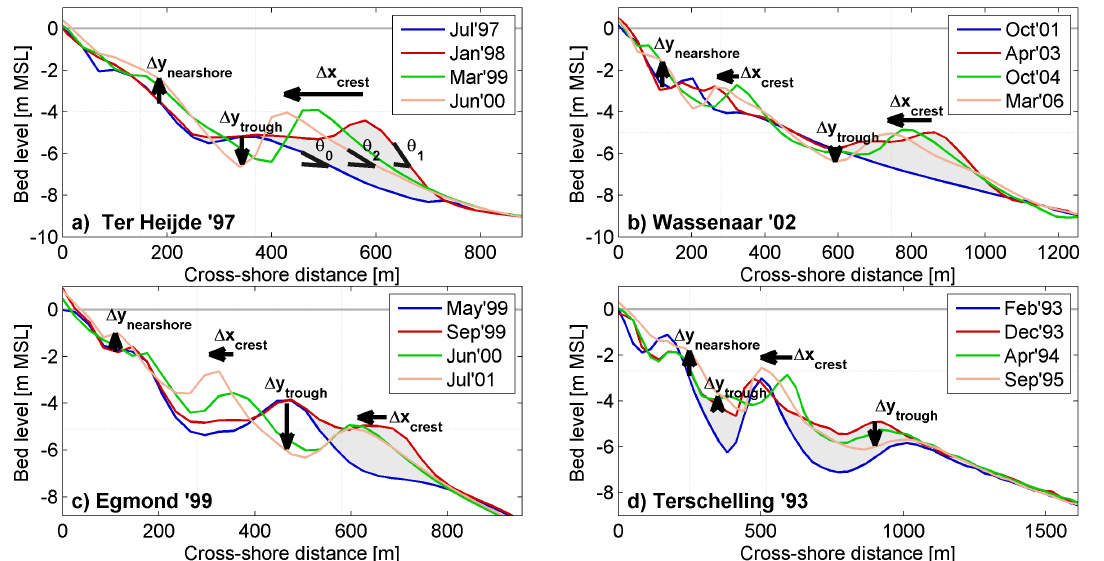
Figure 7. Cross-shore profile changes at 4 representative nourishments for four moments in time. The pre-construction situation is shown in blue. The initial nourishment (at the moment of the first post-construction survey) is shown as a gray area in the